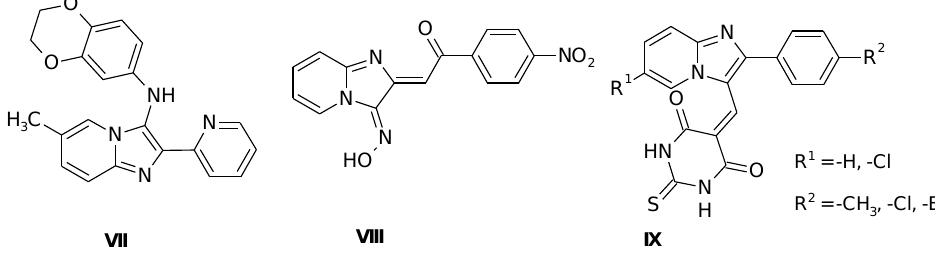
Figure 2. Antibacterial imidazo[1,2- a ]pyridines.